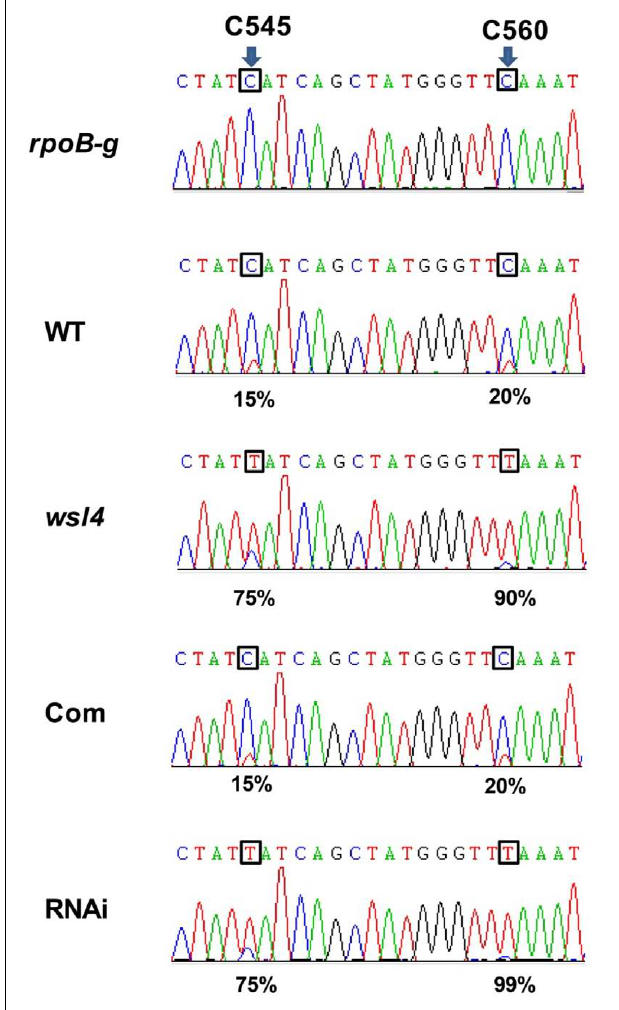
FIGURE 7 | Editing efficiencies of rpoB genes in WT and the wsl4 mutant. RT-PCR products of rpoB transcripts from L3-3 of WT, wsl4 mutant (white striped sector), complemented (Com), and RNAi (white striped sector) plants grown in a growth chamber at L30/D25 were sequenced. In wsl4 mutant and RNAi plants, the editing efficiency of rpoB at C545 and C560 were significantly increased compared to WT and Com. The top panel corresponds to the genomic nucleotide sequence. Green, black, red, and blue peak represent A, G, T, and C, respectively. Arrowheads indicate the editing sites and their position in the corresponding chloroplast cDNA strand. L3-3 indicates the third leaf at the three-leaf stage.